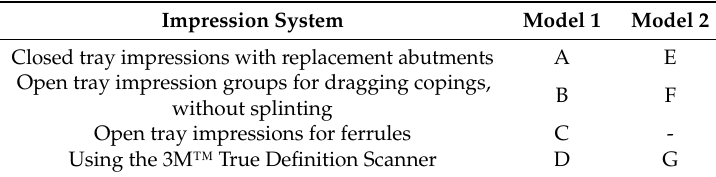
Descriptions of the different impression techniques and models used, with their corresponding